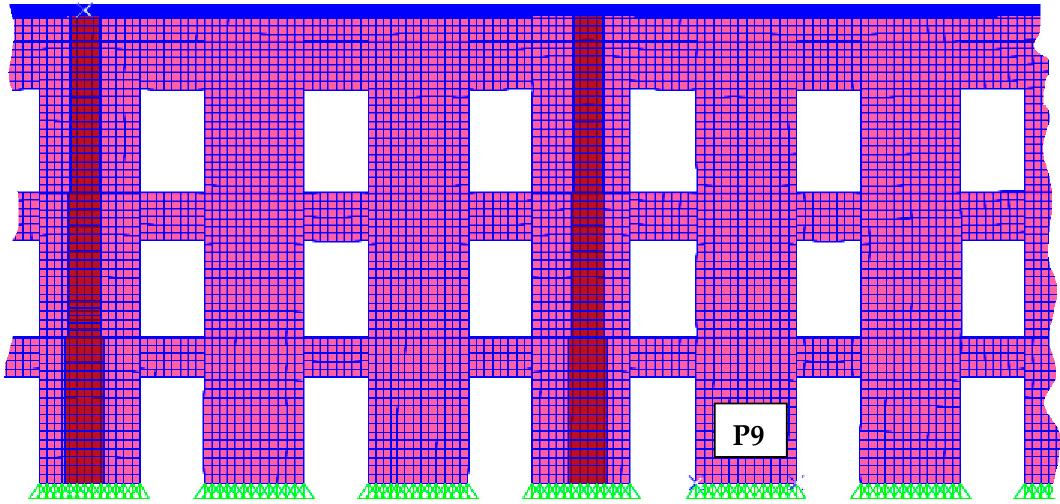
Figure 18. Elevation of wall showing the considered pier P9 (see Figure 10).